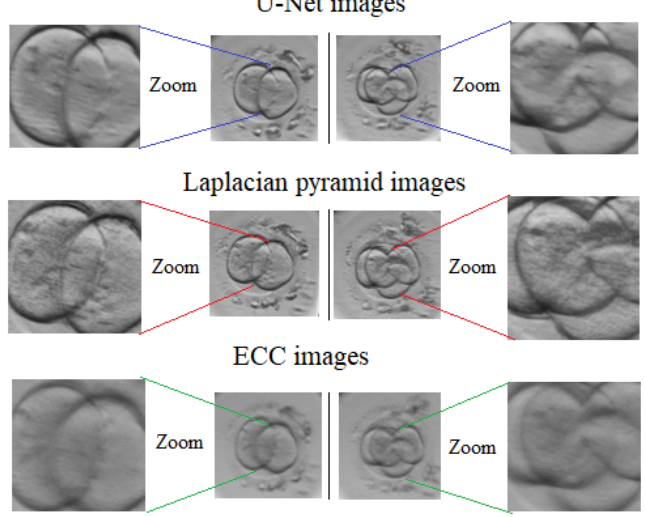
Figure 11. Comparison of the fused images using the proposed multi-focus image fusion approach using U-Net architecture, LP transform and ECC method for 2-cell and 4-cell